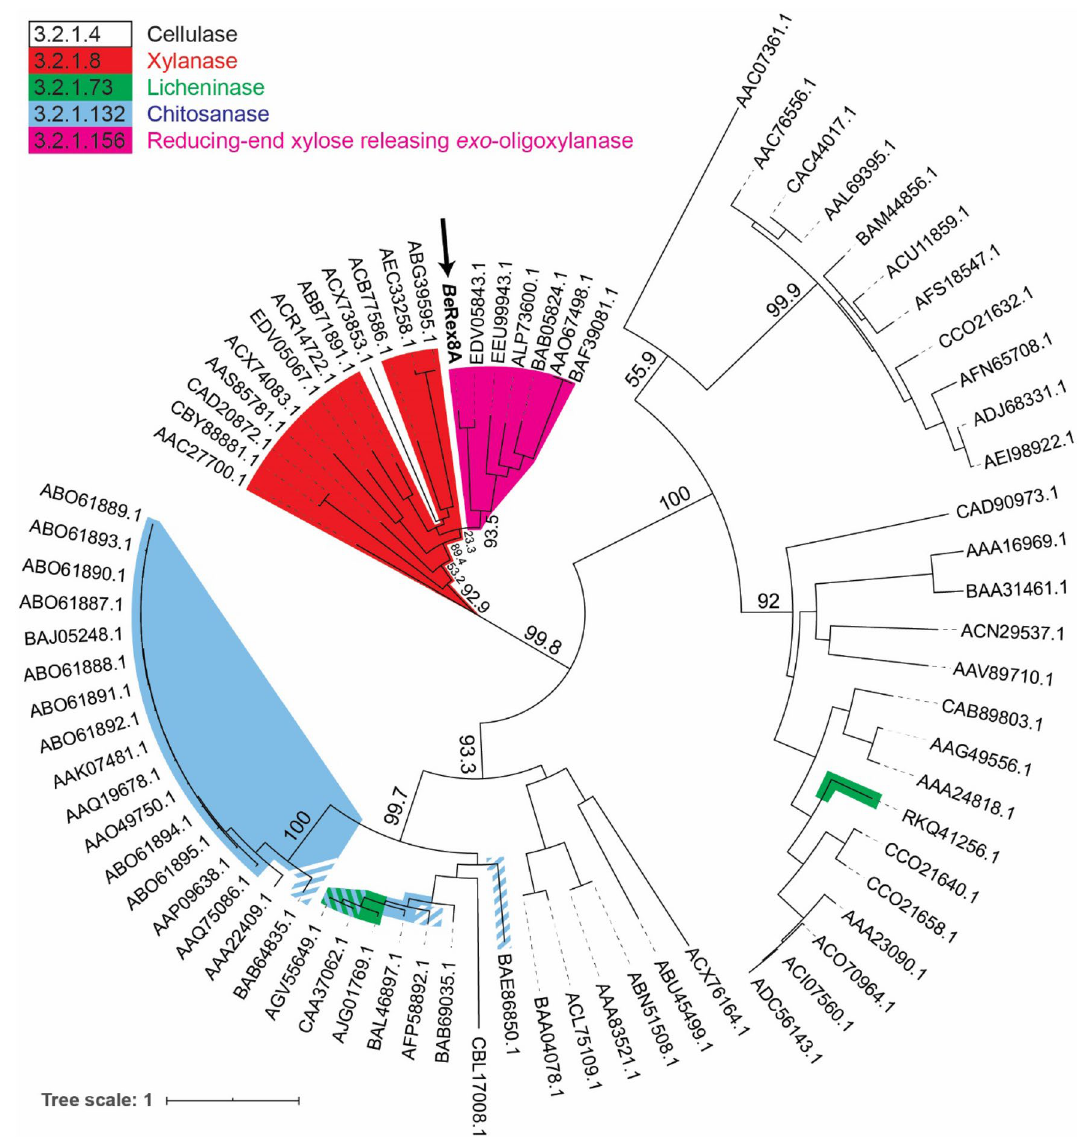
Figure 2. Phylogenetic tree of biochemically characterized GH8 domains. Proteins are labelled with Genbank accession numbers. The C-terminal Rex domain of Be CE15A-Rex8A is indicated in bold and marked with an arrow. Branches are colored by activity, with xylanase in red, Rex in magenta, licheninase in green, chitosanase in blue, and cellulase uncolored. Branches representing enzymes with dual specificity are striped with the corresponding